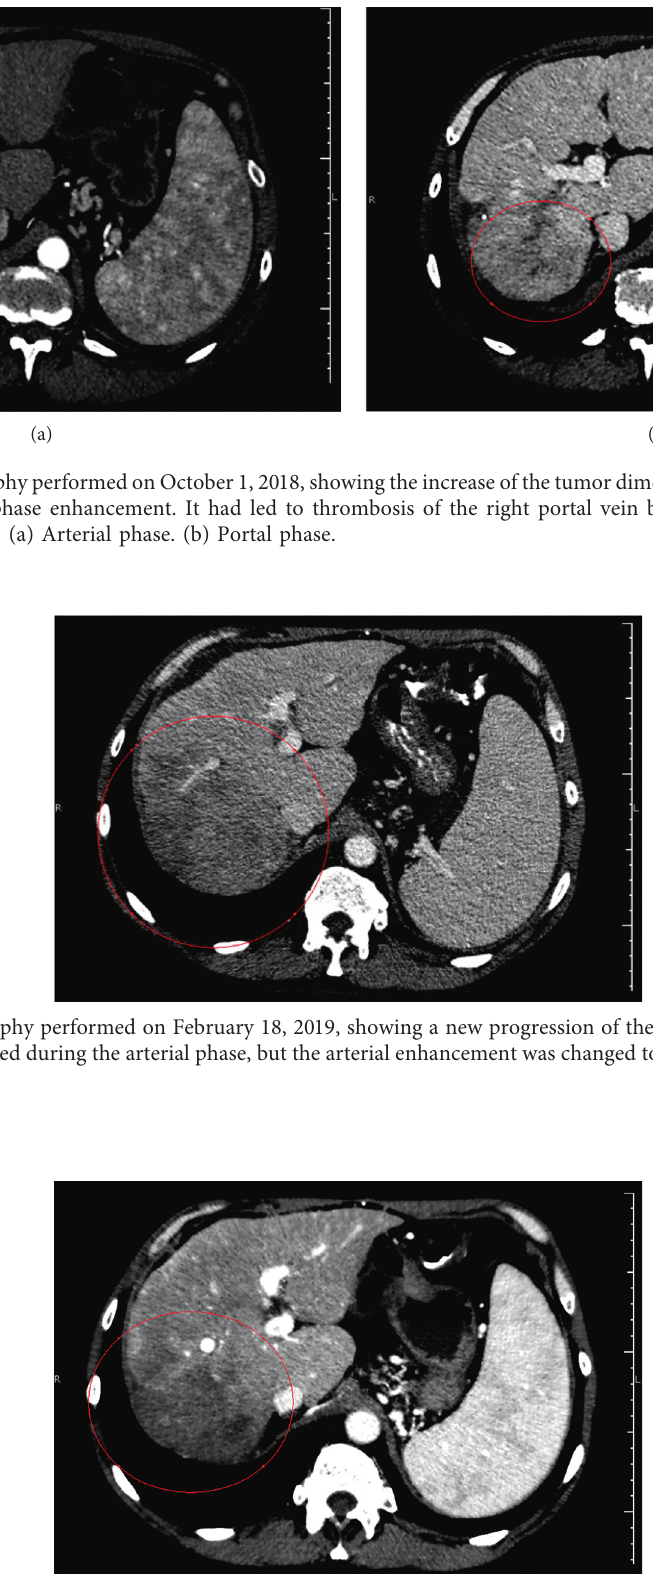
Figure 4: Computed tomography performed on April 8, 2019, showing a clear reduction of the liver tumor in the arterial phase, underscored by the red line. Instead of arterial phase enhancement, the tumor was now fulfilled by necrotic